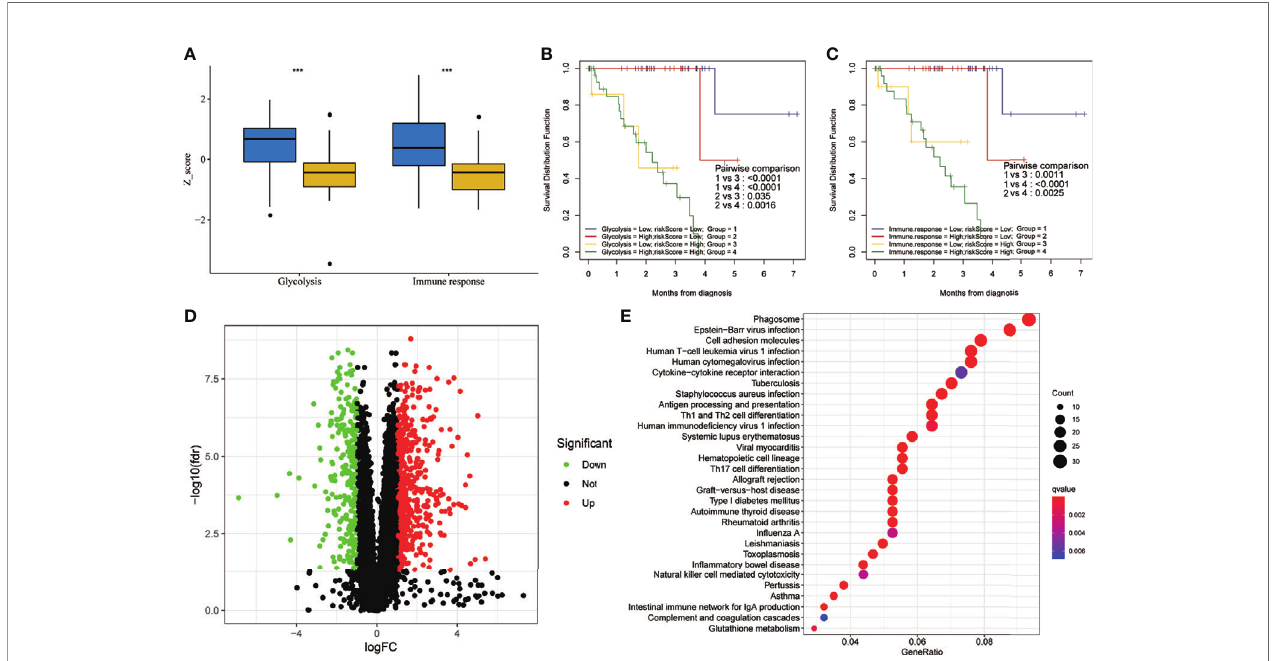
FIGURE 8 | Two-factor survival analysis combining the cancer hallmarks and risk scores in the training set. (A) The glycolysis and immune response Z -scores in the high-risk group were higher than those of the low-risk group. (B) Two-factor survival analysis combining glycolysis and risk scores suggested that high glycolysis Z - scores and high risk scores predicted worse prognosis. (C) Two-factor survival analysis combining immune response and risk scores suggested that high immune response Z -scores and high risk scores predicted worse prognosis. (D) Volcano map showing the DEGs between the high- and low-risk groups in the training set (with |log2FC| > 1, FDR < 0.05 as the cutoff value). (E) Kyoto Encyclopedia of Genes and Genomes (KEGG) analysis of DEGs. FDR , false discovery rate; DEGs , differentially expressed genes. ***p <